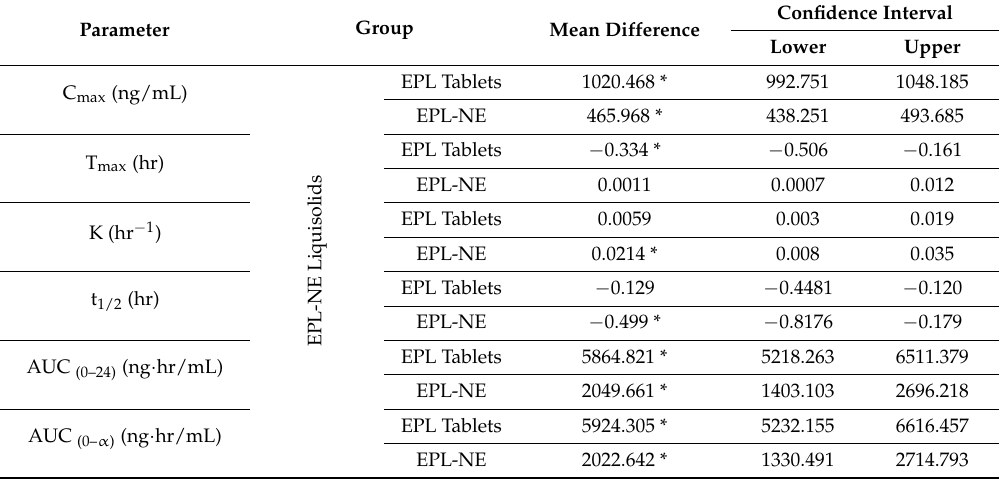
Table 6. Post-Hoc statistical analysis of the calculated means with 95% confidence